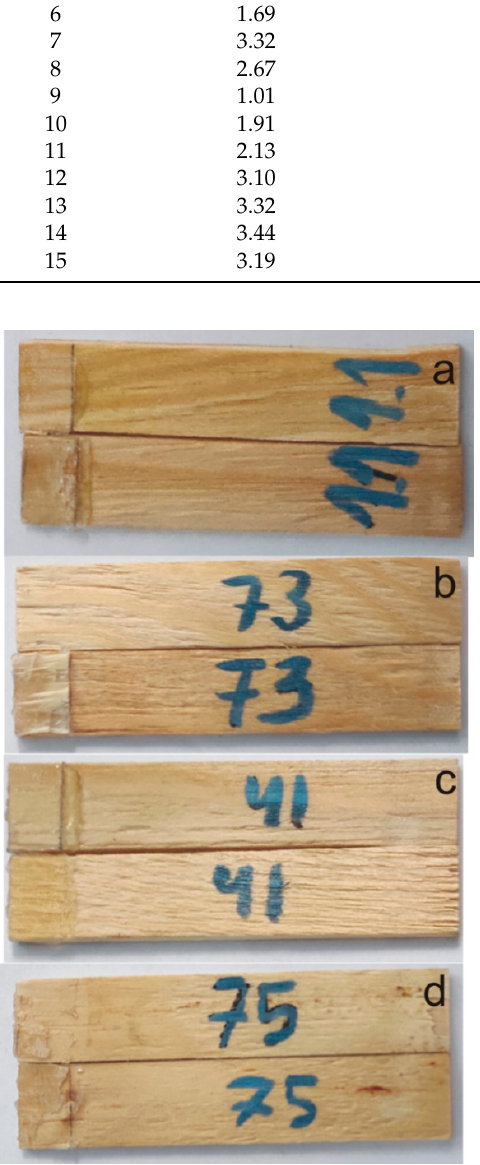
Figure 6. Failure modes observed in the tested specimens: a—adhesive at the binder/wood interface, b—cohesive in wood, c—cohesive in PHU layer, and d—mixed.